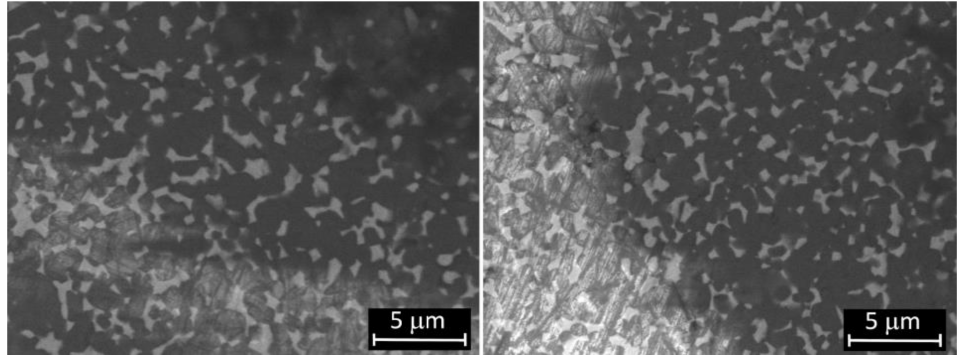
Figure 2. SEM micrographs of ZTA femoral surface before ( left ) and after ( right ) the test. Polyethylene menisci were examined by visual and microscopic inspection. Figures 3 and 4 show UHMWPE meniscus before and after test where scratches are evident on the surface of the sample after wearing cycles. Since the inspected ZTA femoral part is not altered by wear, it is unlikely that ceramic debris are formed during the test. Scratches are therefore attributed to the friction between ceramic and